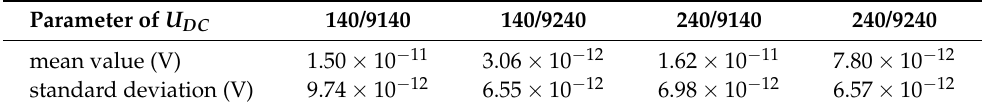
Figure 8. Voltage U DC determined by simulation at load R0 with input capacitors C7 and C8 shorted to ground for: ( a ) 140/9140; ( b ) 140/9240; ( c ) 240/9140; and ( d ) 240/9240 transistor pair. Table 2. Numerical data for Figure